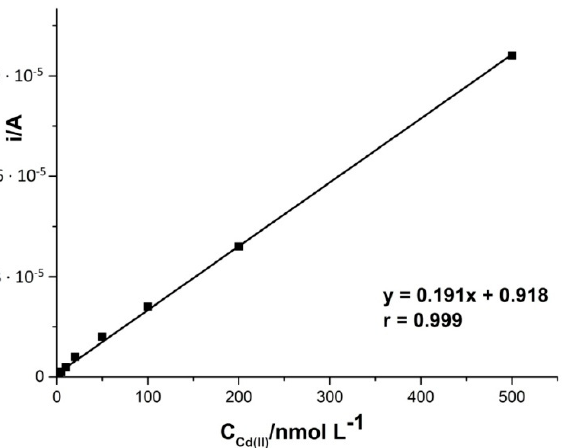
Figure 4. Linear range of the cadmium calibration curve. DPV parameters: accumulation time 210 s, accumulation potential − 0.7 V.